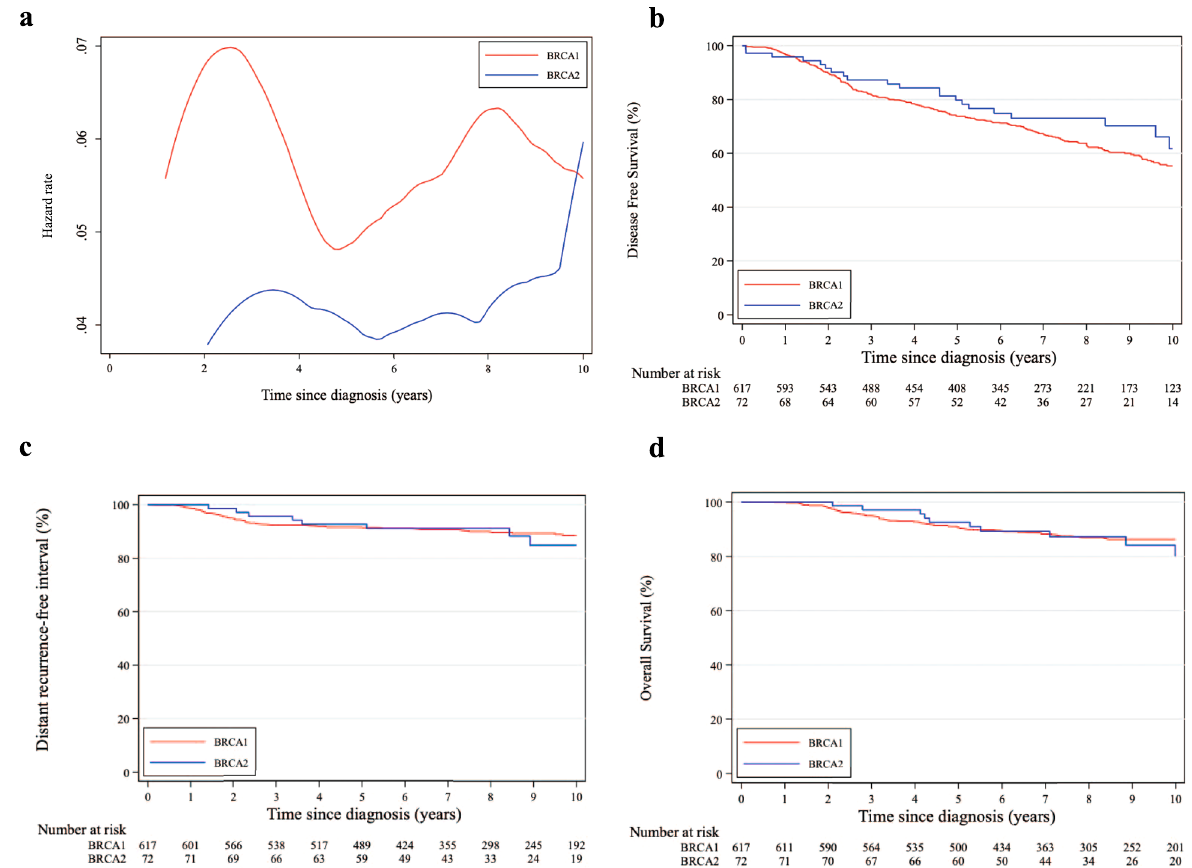
Fig. 3 Comparison between patients with germline BRCA1 and BRCA2 pathogenic variants and hormone receptor-negative disease. a Epanechnikov Kernel-Smoothed annual hazards of recurrence overall; b Disease-free survival; c Distant recurrence-free interval; d Overall survival.